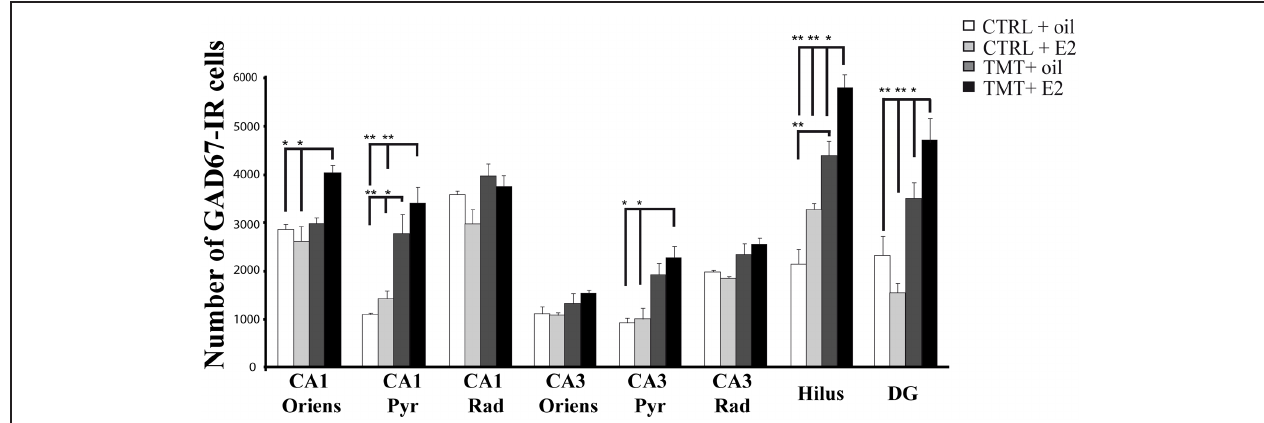
FIGURE 5 | Quantitative analysis of glutamic acid decarboxylase 67 (GAD67)-immunoreactive (IR) neurons in the hippocampus of animals of the different experimental groups. Bar graphs indicate that a significantly higher number of GAD67-IR cells is present in the CA1 pyramidal layer and in the hilus of both TMT-treated groups. A further significant increase in the number of GAD67-IR neurons localized in the CA1 and CA3 pyramidal cell layers and in CA1 stratum oriens is evident in the TMT + E2-treated rats compared with both control groups and in the DG and hilus of the same group compared with all other groups. The values are given as means ± SE ( ∗ p < 0.05, ∗∗ p <